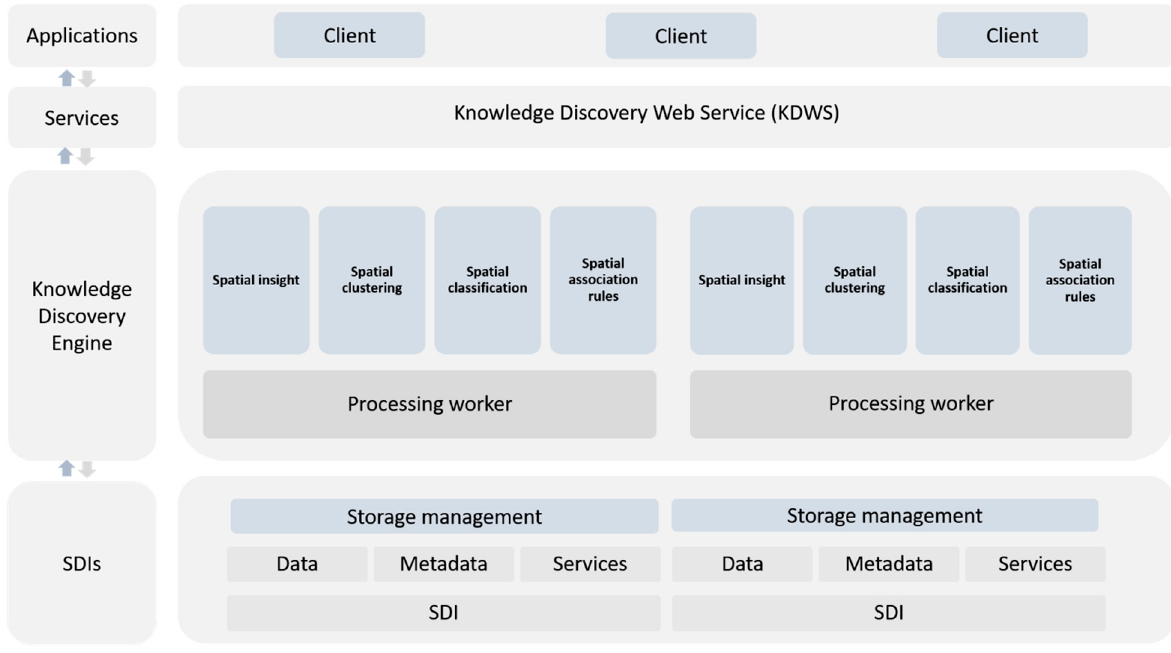
Figure 2. Proposed framework for extracting knowledge from spatial